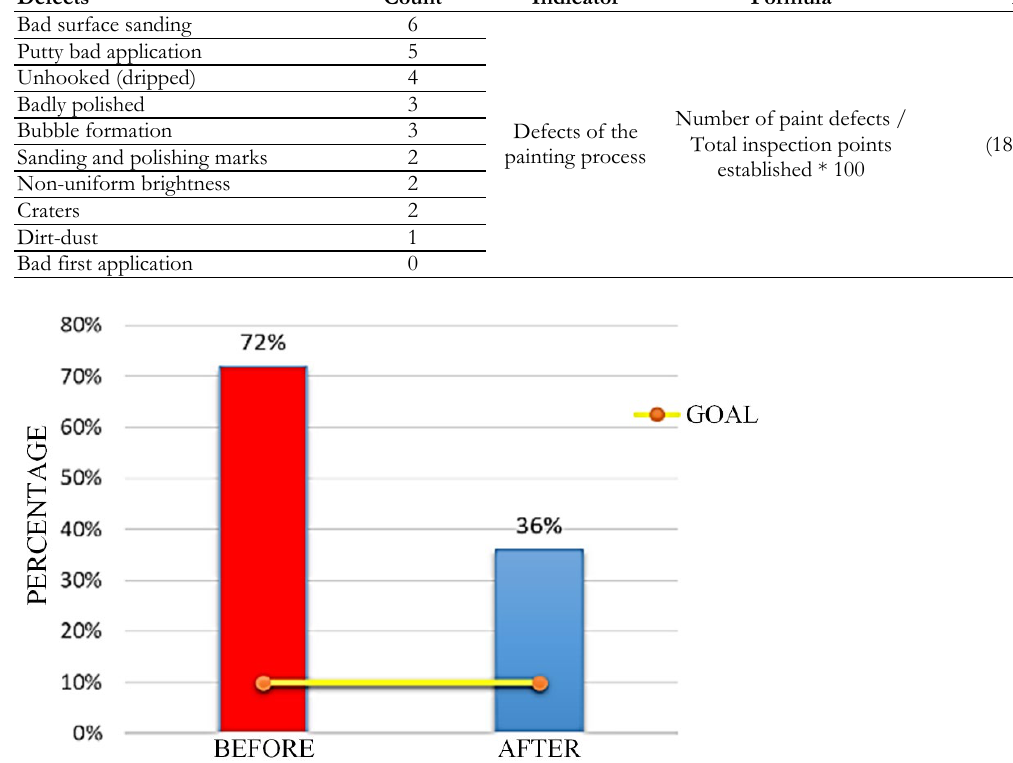
Table 7. Defects on the Paint process (After improvement)